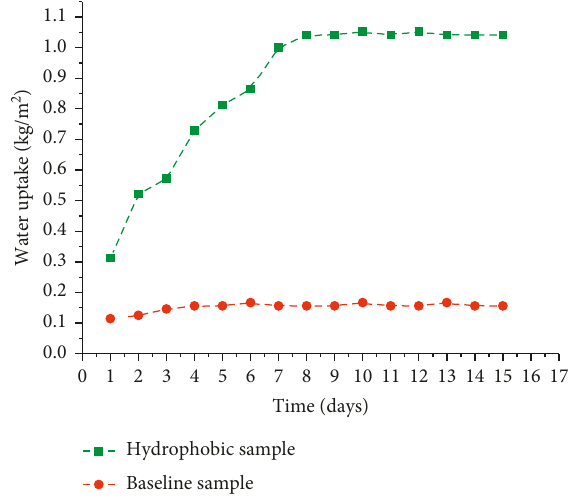
Figure 4: Water absorption results for the baseline and hydro- phobic